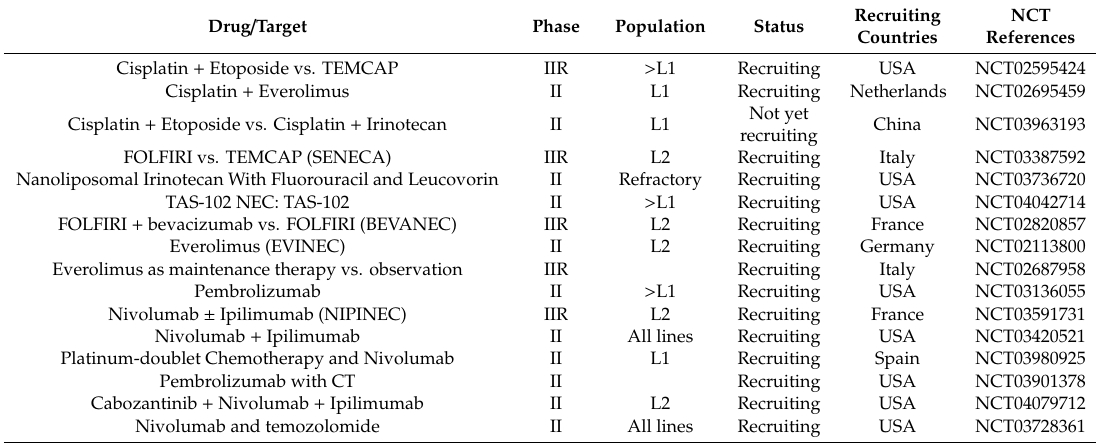
Table 2. Selected ongoing clinical trials on medical treatments in advanced / metastatic